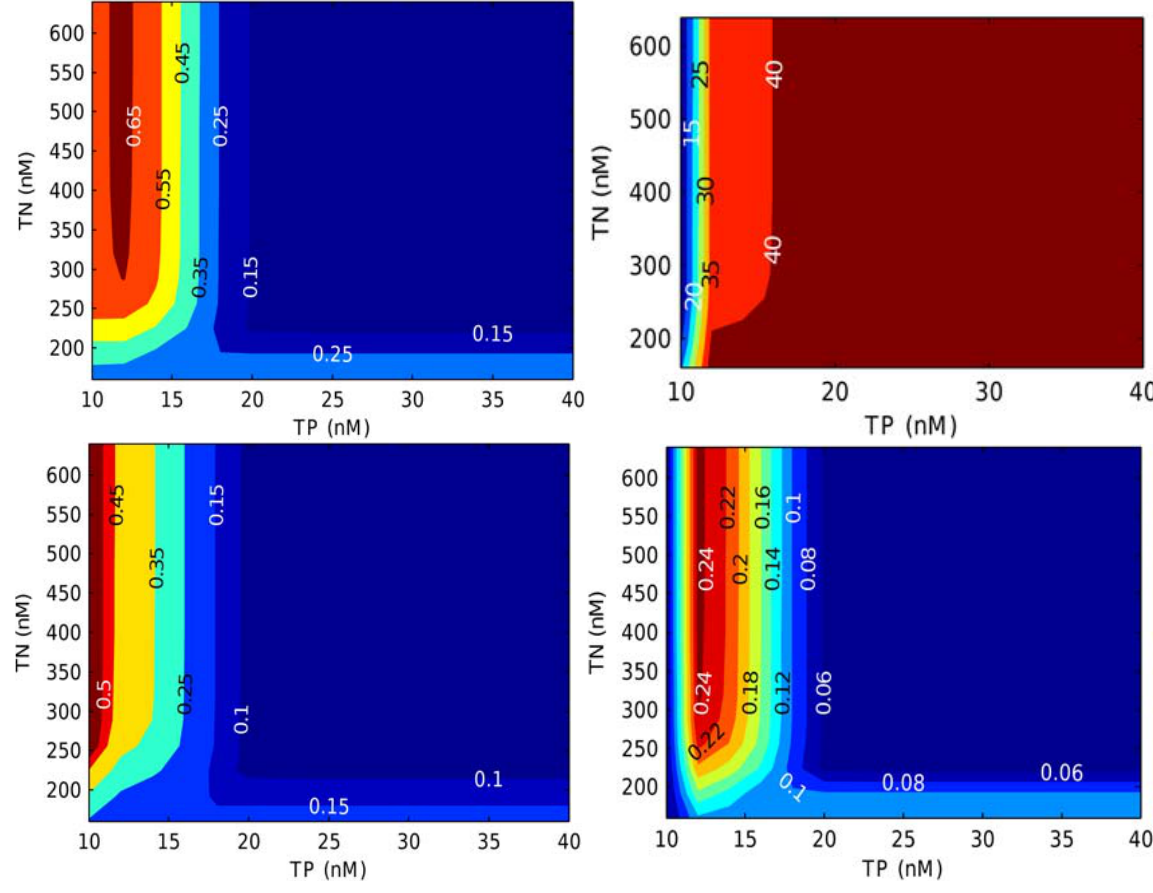
Fig. 7. Bacterial carbon demand (BCD), bacterial growth efficiency (BGE), Bacterial respiration rate (BR) and Bacterial production (BP) as a function of TN and TP.